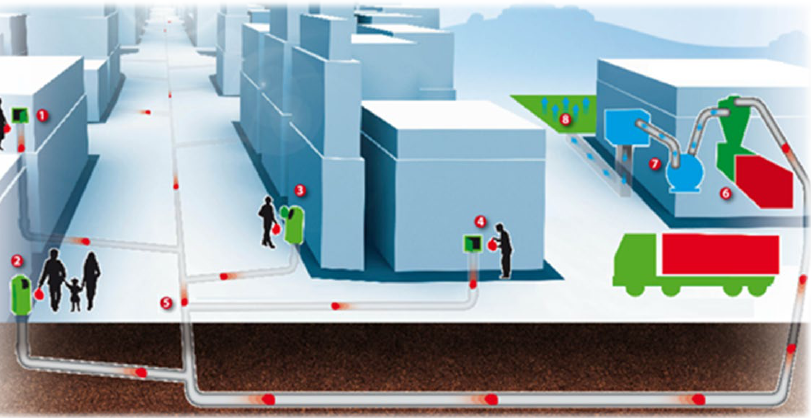
Figure 1. AWCS scheme. (1) Indoor inlets (on each floor), (2) outdoor inlets (with domestic door), (3) outdoor inlets (with professional door), (4) indoor inlets (on ground floor), (5) pipeline network, (6) separation and compaction unit (terminal), (7) blowers—de-pressurisation system, and (8) air treatment system. Source: URD.